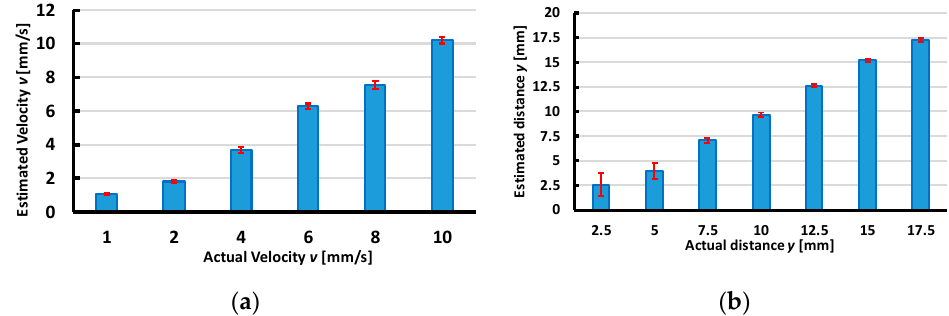
Figure 21. Calculated results compare to actual values with X-sliding case. ( a ) Comparison of calculated and actual velocity 𝑣 (mm/s) . ( b ) Comparison of calculated and actual distance 𝑦 (mm) .